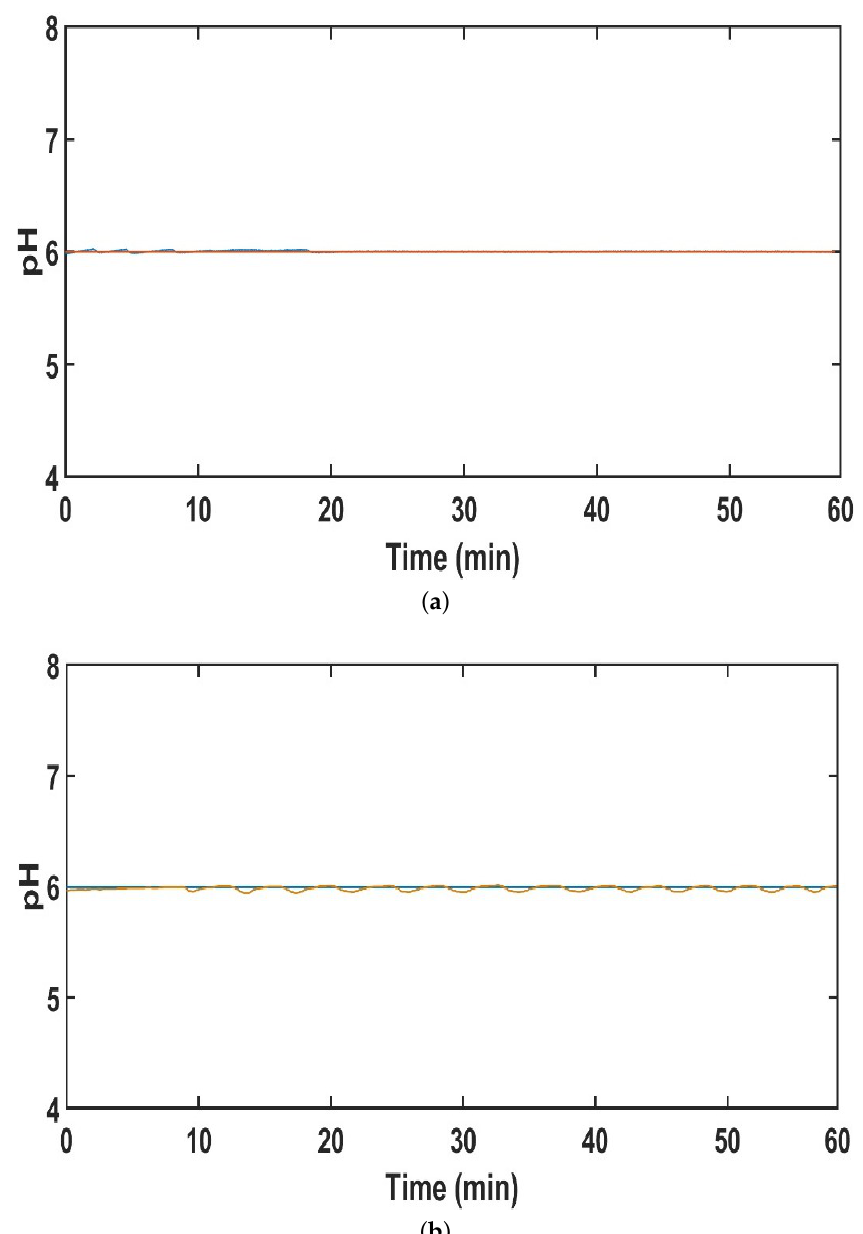
Figure 10. The figure shows the result of the pH control for the simulated and real processes, respectively, maintaining the value of the reference the whole time, with a reference value of pH = 6 for simulation and pH = 7 in a stirred tank with a volume of 1500 L for scaled-industrial process. ( a ) pH reference and pH measured for simulation, ( b ) pH reference and pH measured for industrial- scale